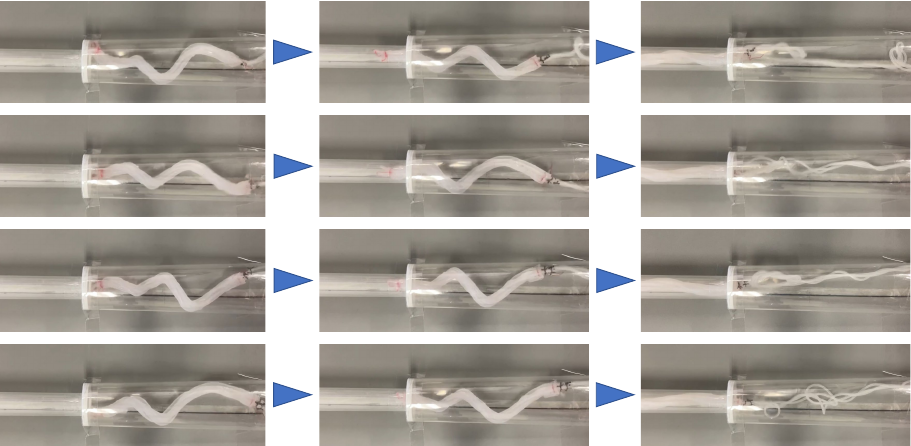
Figure 14. Results of four experiments conducted under the same driving conditions as in Figure 13.